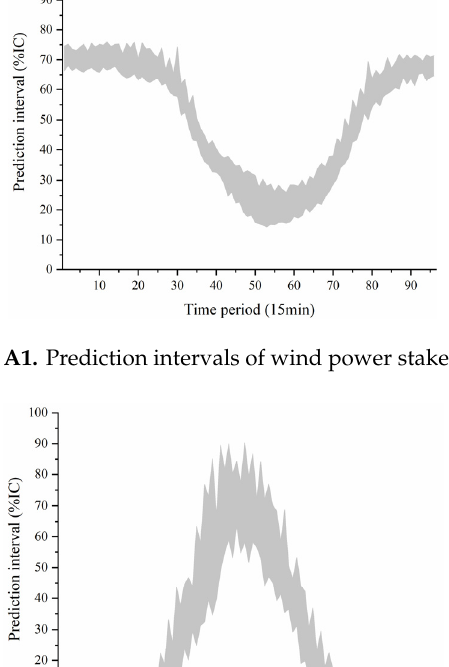
Figure A3. Natural inflow of a cascade of two hydro power stakeholders.